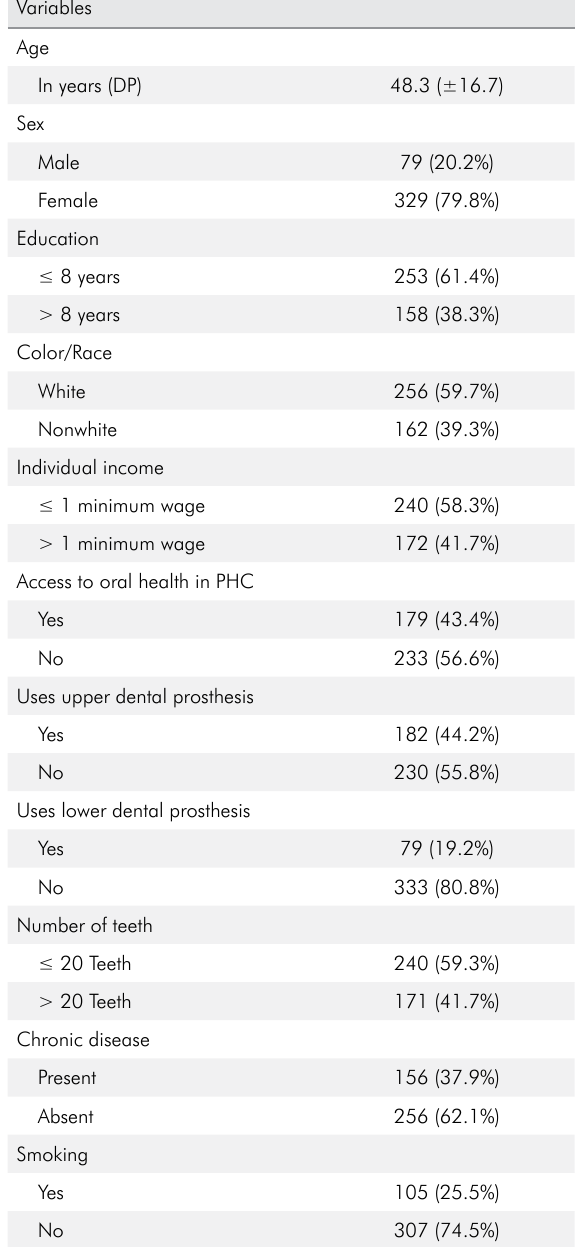
Table 1. Characterization of the sample of users of primary health care services in Porto Alegre, Rio Grande do Sul, Brazil, 2013 (n =